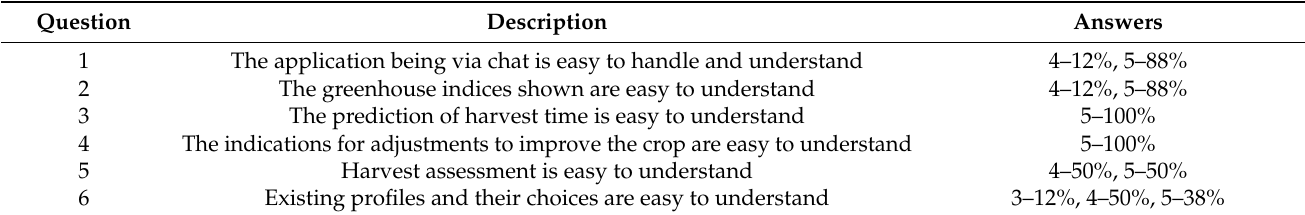
Table 7. Items related to assessment of the perceived ease of use of